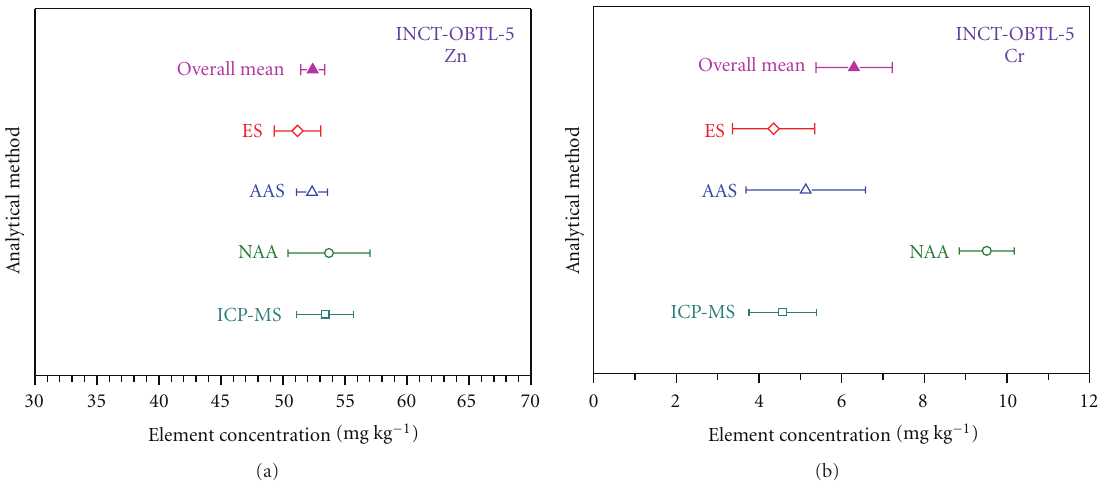
Figure 7: Comparison of the finally calculated overall mean (from the alternative database) for Zn and Cr in INCT-OBTL-5 and the means obtained for particular analytical techniques, together with the respective confidence intervals.